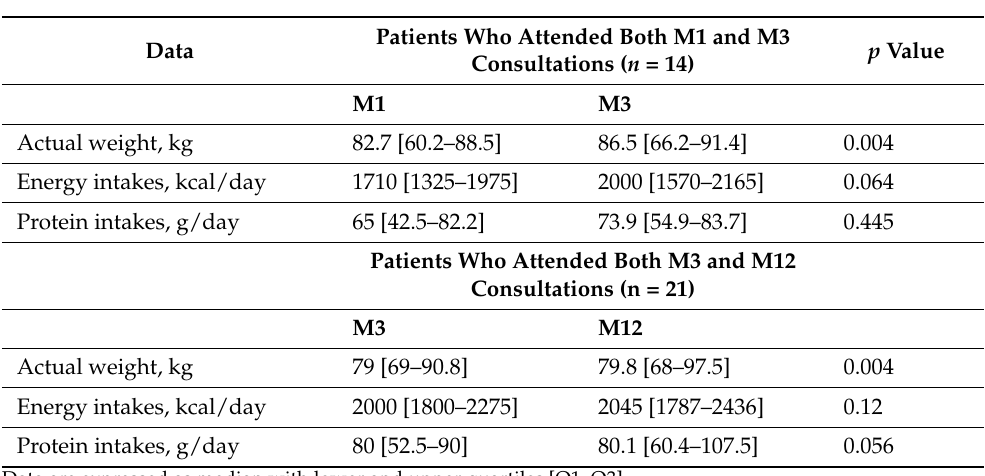
Table 5. Evolution of weight and nutritional intakes over time in patients who attended more than one follow-up